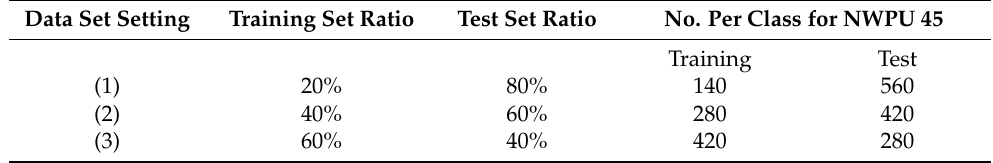
Table 2. The settings of the data